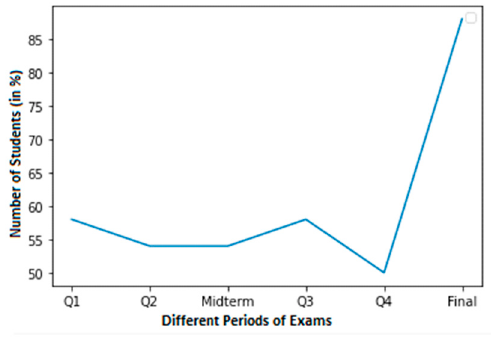
Figure 3. A high cheating dataset of students with cheating found.